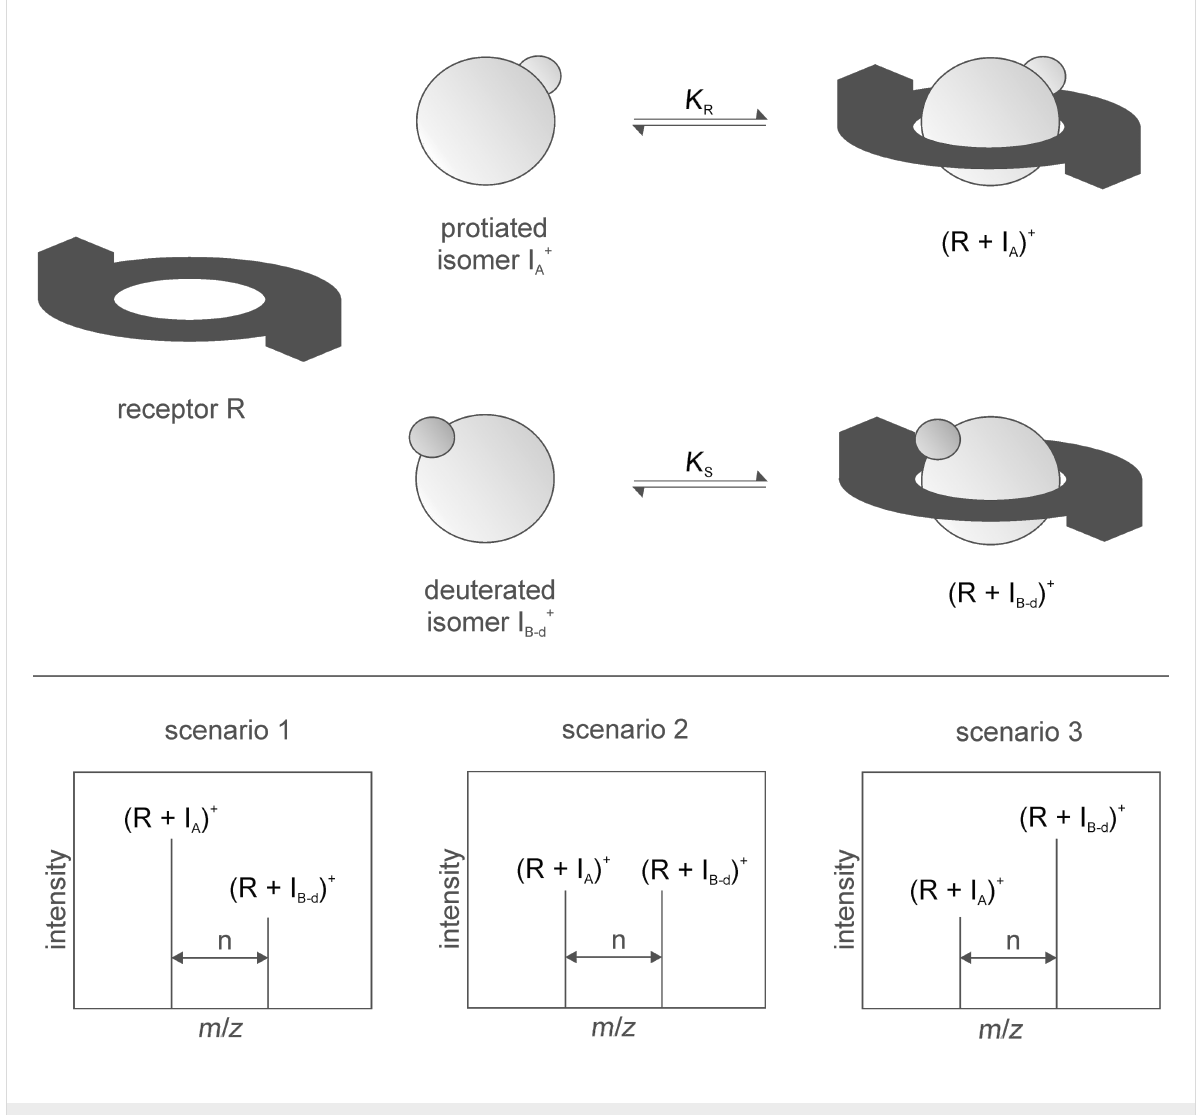
Figure 3: Schematic presentation of the isomer labelled guest method (ILGM).